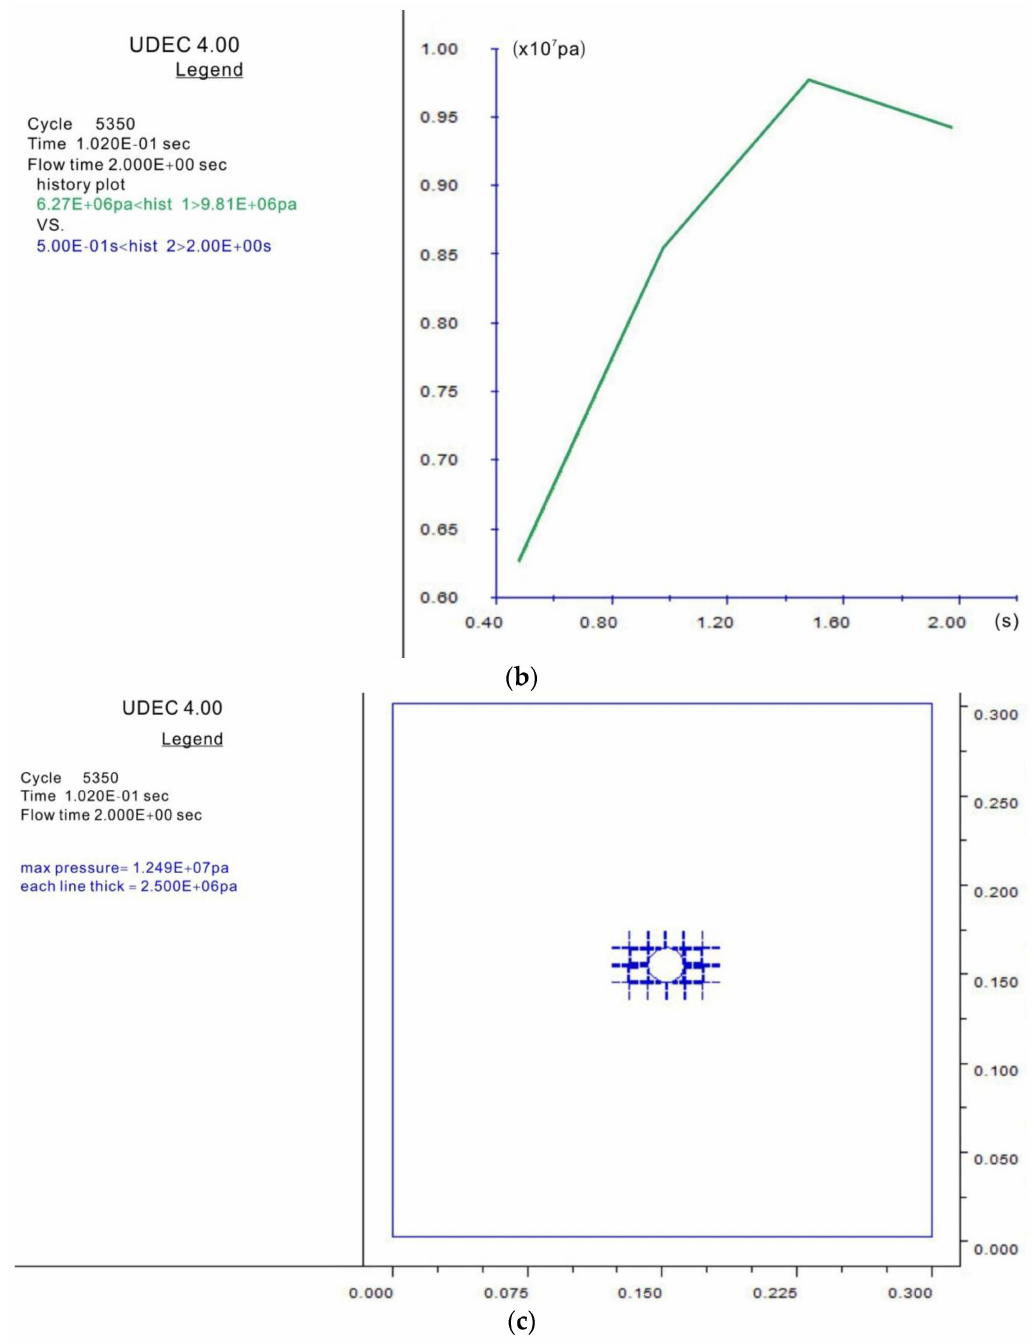
Figure 3. The hydraulic fracturing characteristics at the time of 2 s. ( a ) fracture geometry; ( b ) injection pressure curve; ( c ) distribution of pore